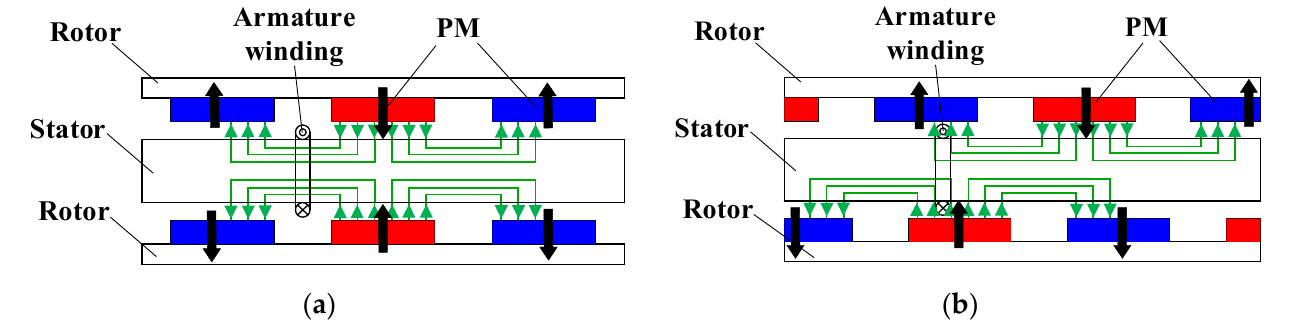
Figure 15. Flux mechanically controllable by shifting PM rotors [8]. ( a ) Flux ‐ enhancing state. ( b ) Flux ‐ weakening state.